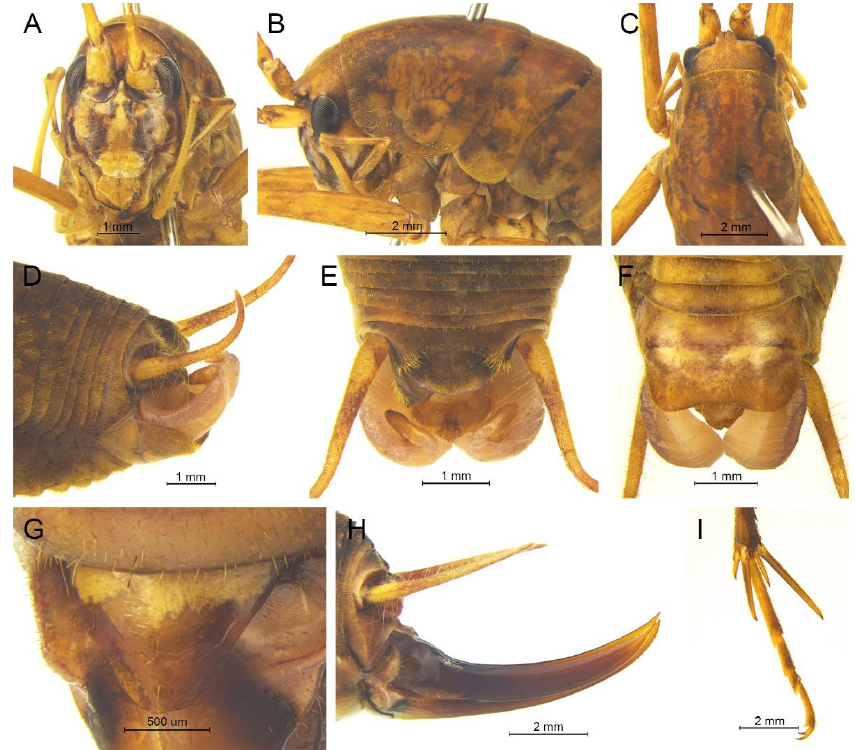
Figure 18. Homotachycines ovalilobatus comb. nov., male: ( A – C ) head and pronotum: ( A ) frontal view, ( B ) lateral view, ( C ) dorsal view; ( D – F ) apex of abdomen: ( D ) lateral view, ( E ) dorsal view, ( F ) ventral view; ( I ) hind tarsus in lateral view; female: ( G ) subgenital plate in ventral view; ( H ) ovipositor in lateral